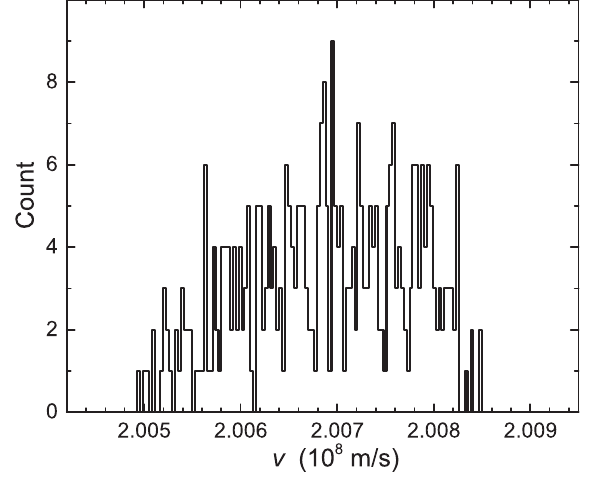
FIG. 4. Velocity distribution of all 45 V 23 þ ions in this experi- ment extracted from Δ t values. coi